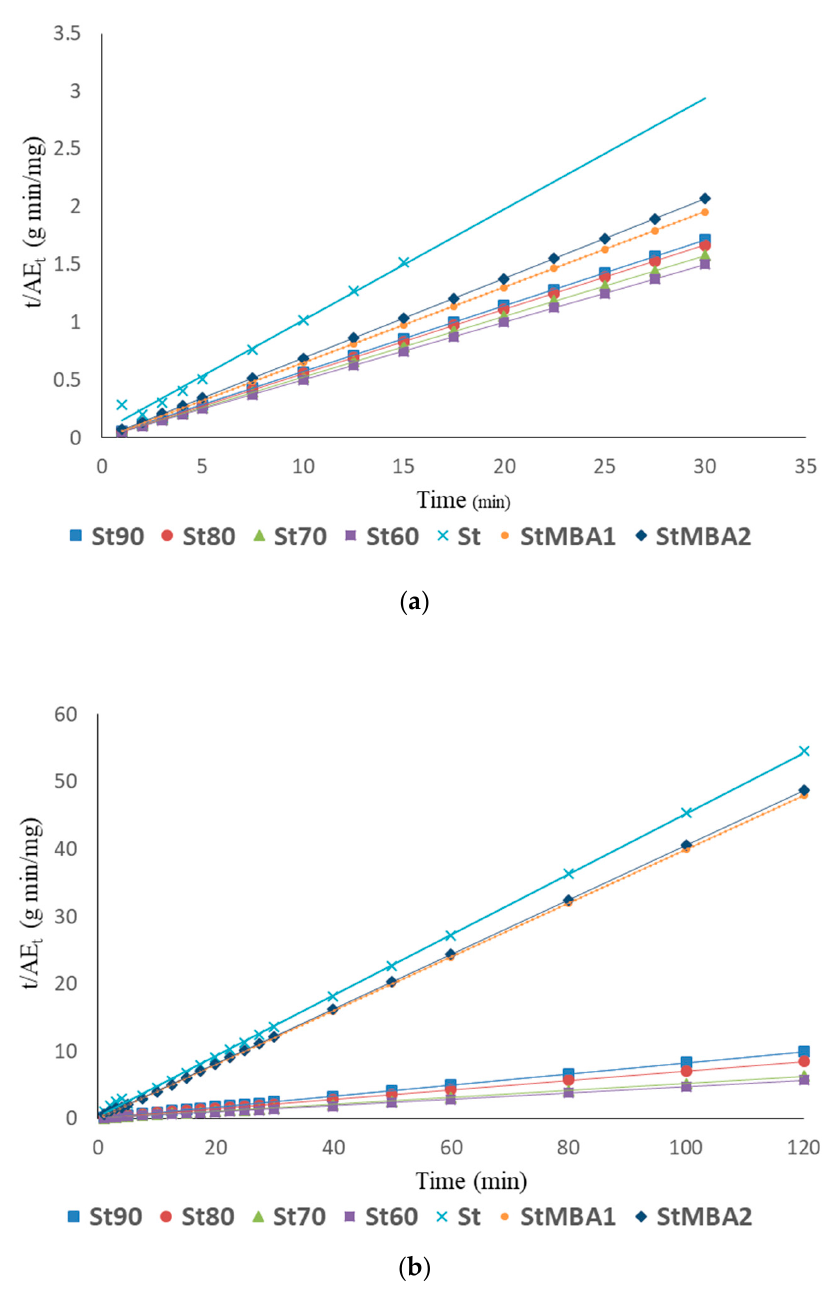
Figure 9. Second order plots for St, StMBA1, StMBA2 and starch SAPs with different amount of natural polymer ( a ) for Cu(II)—initial concentration 50 Cu(II) mg/100 cm 3 ; ( b ) for Fe(III)—initial concentration 50 Fe(III) mg/L.